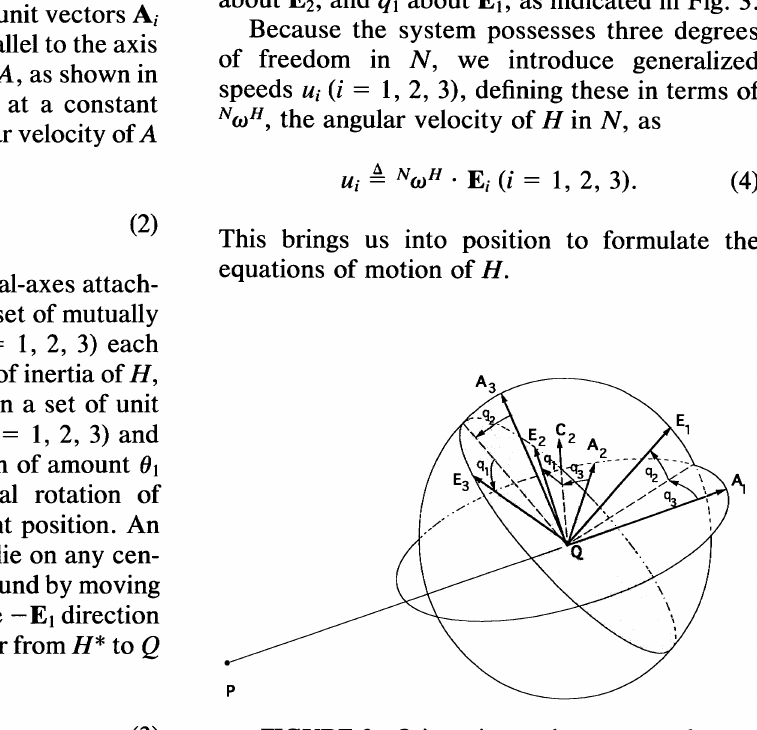
FIGURE 3 Orientation angles qh q2. and